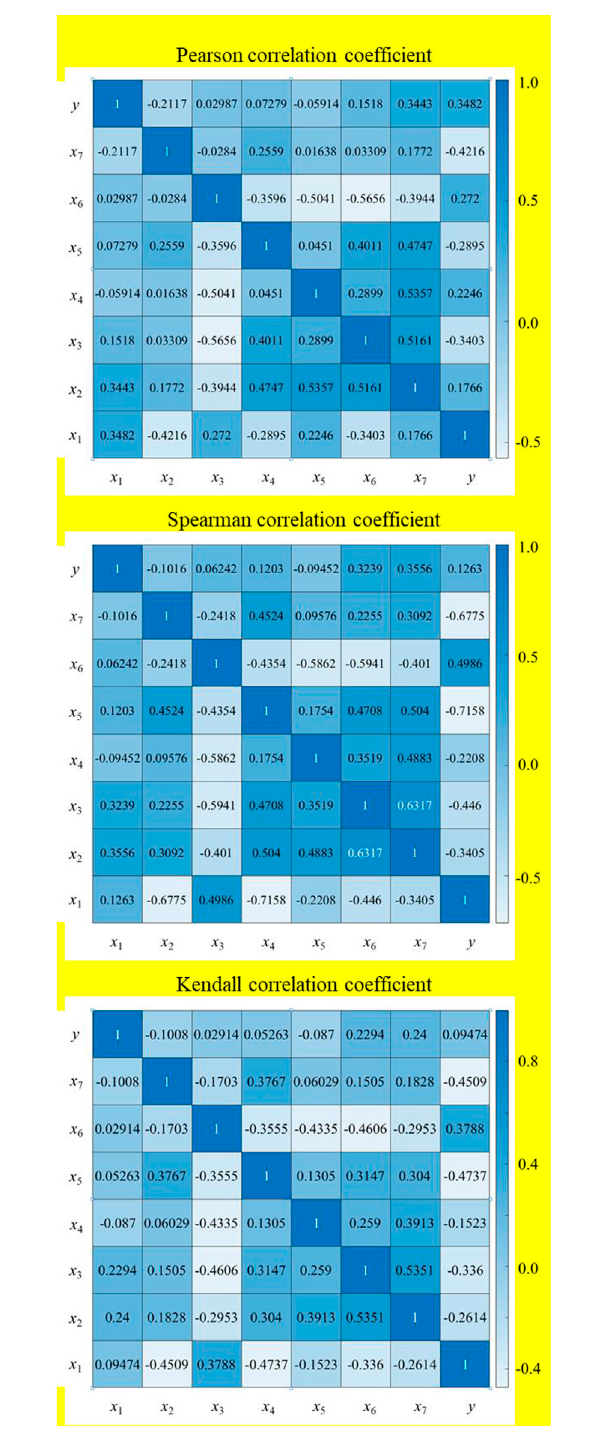
FIGURE 4 | Correlation coef fi cient results.